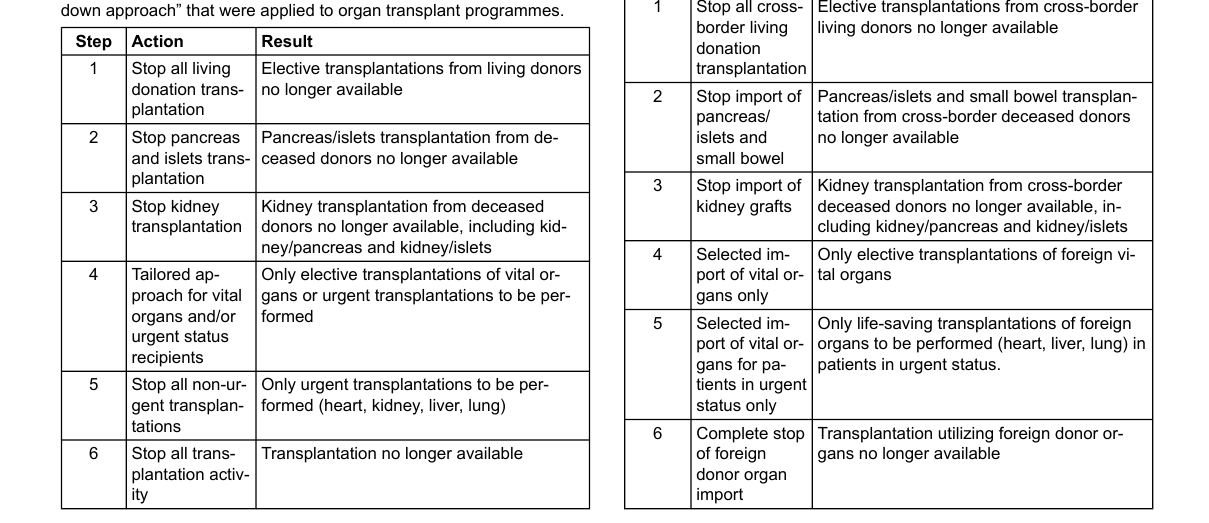
Table 2: The steps of the “Swiss COVID-19 pandemic stepwise shut- down approach” that were applied to organ transplant programmes.